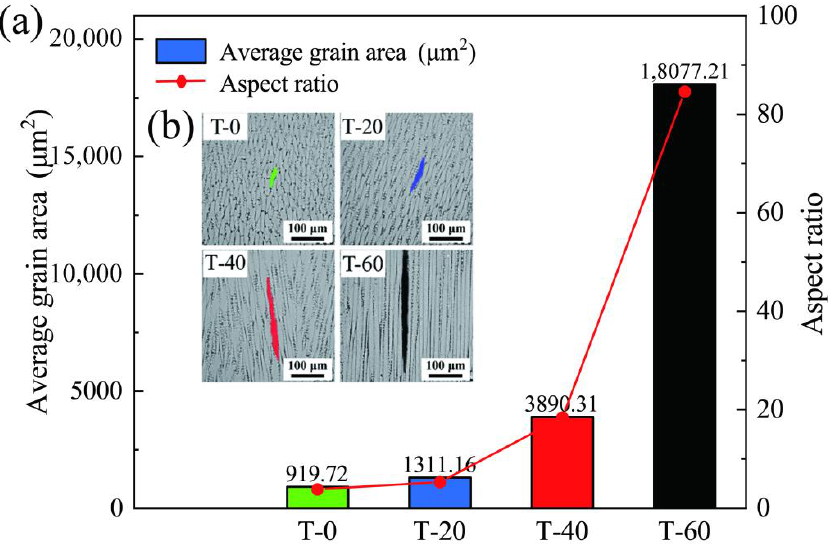
Figure 16. The LMD-Al 0.5 FeCoCrNi walls under different heat dissipation rates: ( a ) Average grain area and aspect ratio; ( b ) Microstructure.